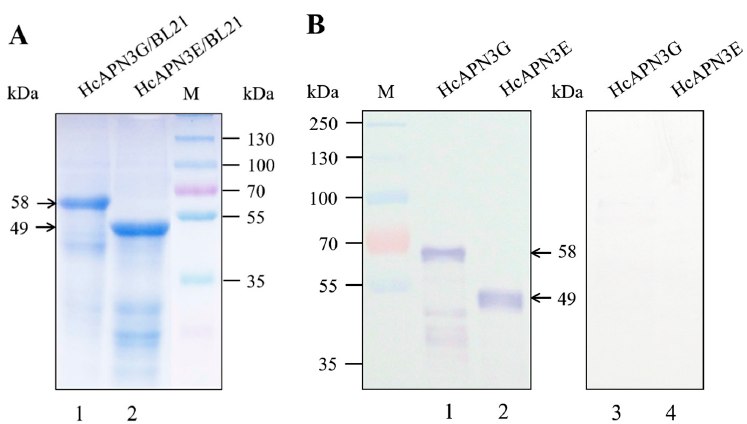
Figure 5. HcAPN3G and HcAPN3E fragment peptides expressed in E.coli BL21 (DE3) cells. HcAPN3G (lane 1) and HcAPN3E (lane 2) peptides expressed in E. coli BL21 (DE3) cells were separated by 10% SDS-PAGE, and either stained with Coomassie Brilliant Blue R-250 ( A ) or transferred to a PVDF membrane and probed by Cry1Ab35 toxin in ligand blot assay ( B ) with anti-Cry1Ab35 antibodies. Lane 3 and 4 was HcAPN3G and HcAPN3E control without Cry1Ab35 toxin ligand respectivily. Lane M shows molecular weight markers and arrows indicate the 58 kDa HcAPN3G and 49 kDa HcAPN3E protein bands.